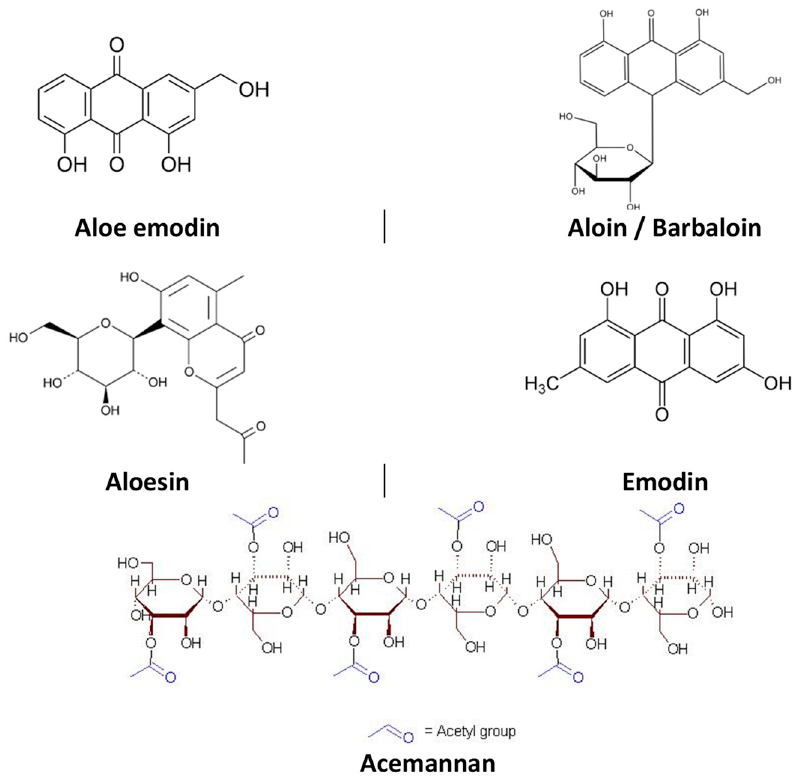
Molecules 2020 , 25 , x FOR PEER REVIEW Figure 1. Chemical structure of compounds isolated from Aloe vera with pharmacological activity.